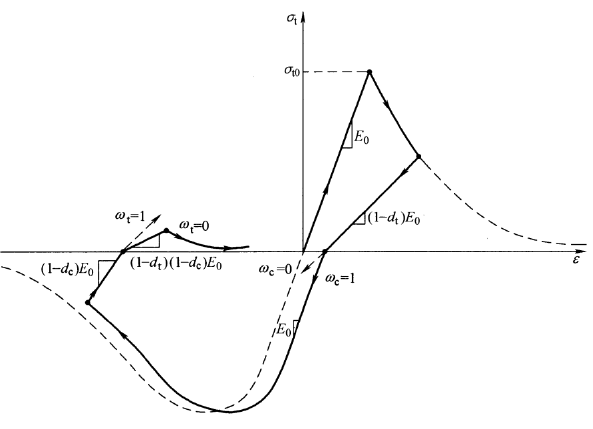
Figure 3. Constitutive relation curve of uniaxial cyclic tension ‐ compression of concrete [14].